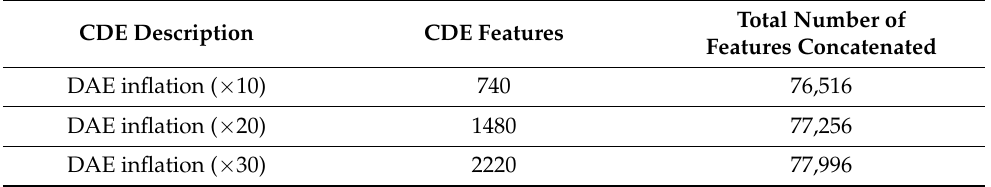
Table 10. Description of tests to validate the implementation of DAE. Tests were implemented in conjunction with the same architecture as the EMM-LC 75K model.